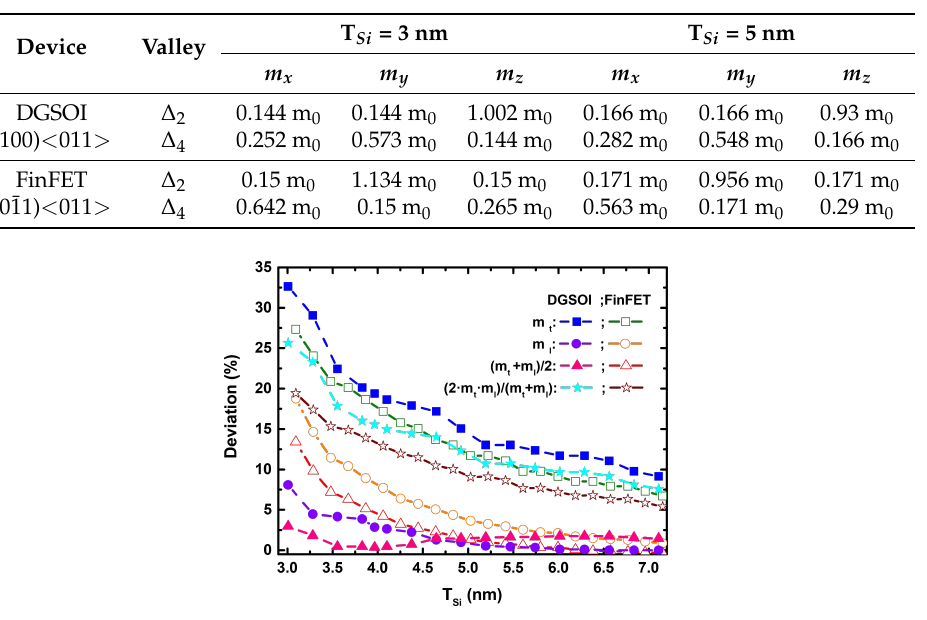
Figure 2. ( a ) Longitudinal ( m l ) and ( b ) transverse ( m t ) effective masses calculated using Density Functional Theory (DFT) as well as the bulk effective masses as a function of the silicon thickness (T Si ) for DGSOI ((100) Confinement Orientation) and FinFET ((0¯11) Confinement Orientation) devices. Table 2. Effective masses (m ef f ) considering the DGSOI and FinFET devices herein studied with silicon thickness T Si = 3–5 nm using DFT simulations included in QuantumATK of Synopsys [19]. Notice that m x and m z are the transport and confinement masses, respectively, m y is the mass in the direction normal to transport, m 0 is the free electron mass, and the subindex of ∆ represents the degeneracy factor associated with the conduction band valley.